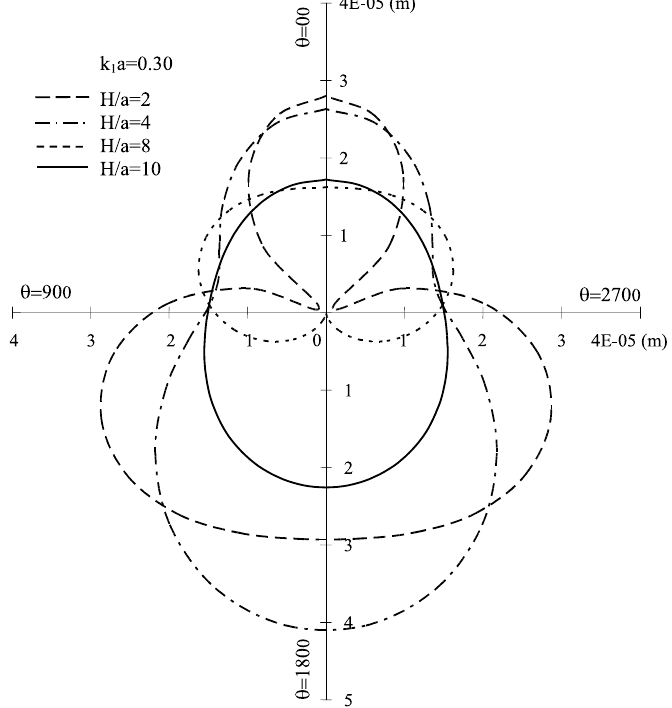
Fig. 6. Variation of the radial displacement ( u r ) with θ at r = a for various values of depth H/a .